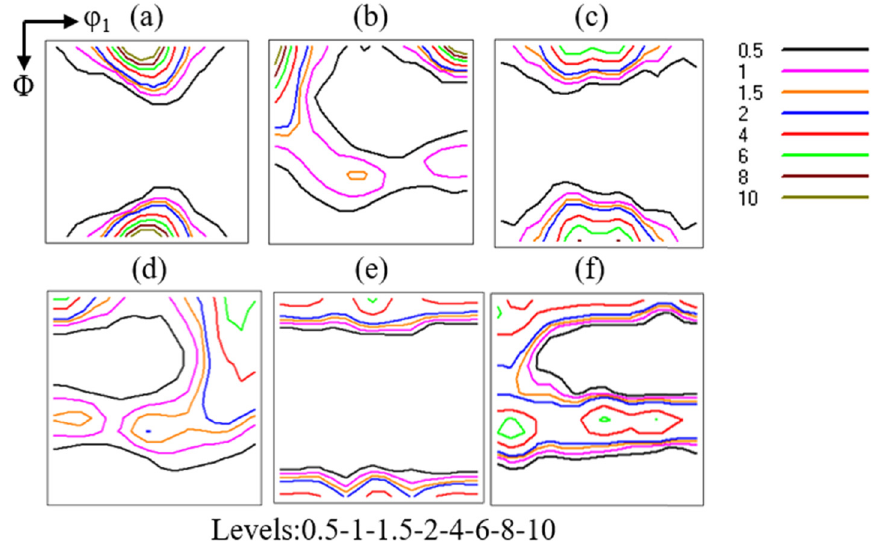
Figure 8: ODF diagram of di ff erent cold - rolling deformation of grain - oriented silicon steel: ( a ) 86% Y - free φ 2 = 0°; ( b ) 86% Y - free φ 2 = 45°; ( c ) 86% Y - bearing φ = 0°; ( d ) 86% Y - bearing φ 2